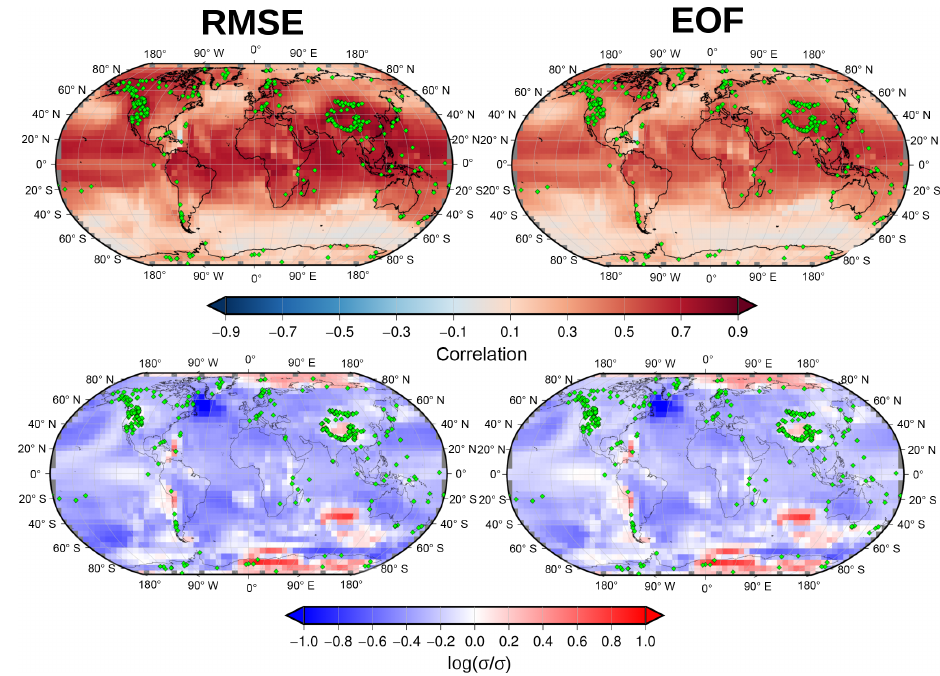
Figure 5. Similar to Figs. 2 and 3 but for realistic PPE. Top (bottom) row indicates the correlation (ratio of standard deviations) between the original simulation used as a target and the reconstructions obtained selecting analogues from the PMIP3